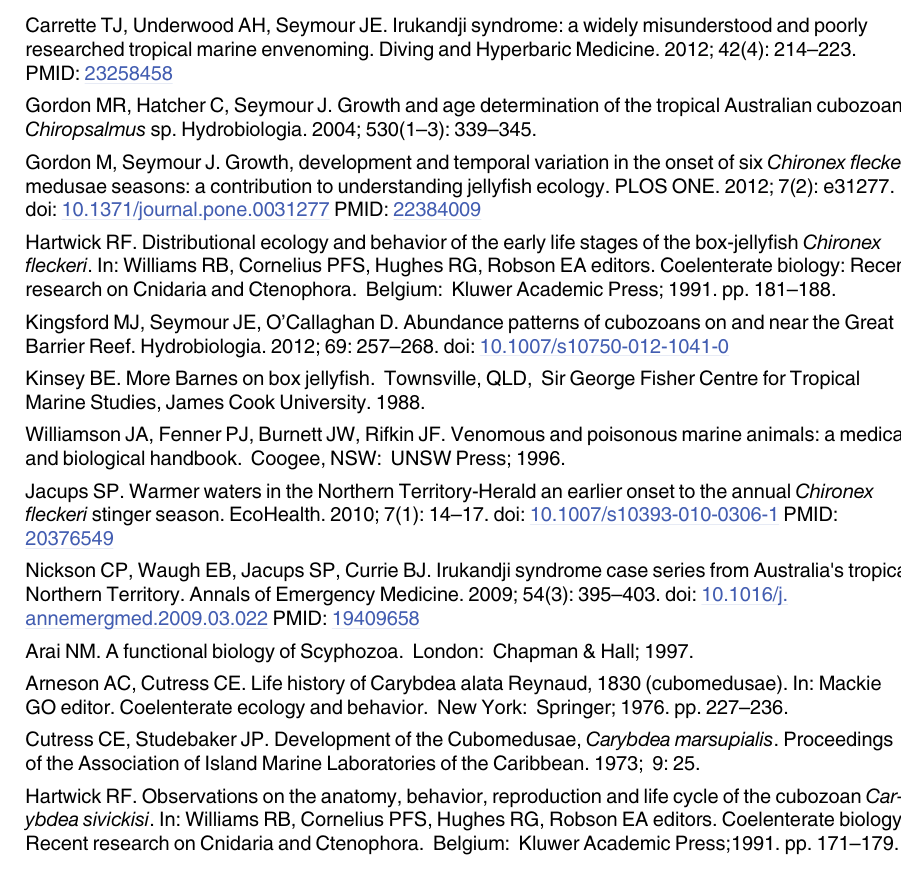
S1 Table. Mean Values and Standard Errors of the Number of Polyps Present after Six Weeks Exposure to a Matrix of Eight Temperatures and Ten Salinity Treatments. All values were calculated as the relative change in polyp density and are presented as proportional change, where values above one indicate population increase through asexual reproduction and values below one indicate polyp mortality. There were six independent replicates for each treatment, therefore n = 6 for all means presented below and standard errors were calculated assuming a normal